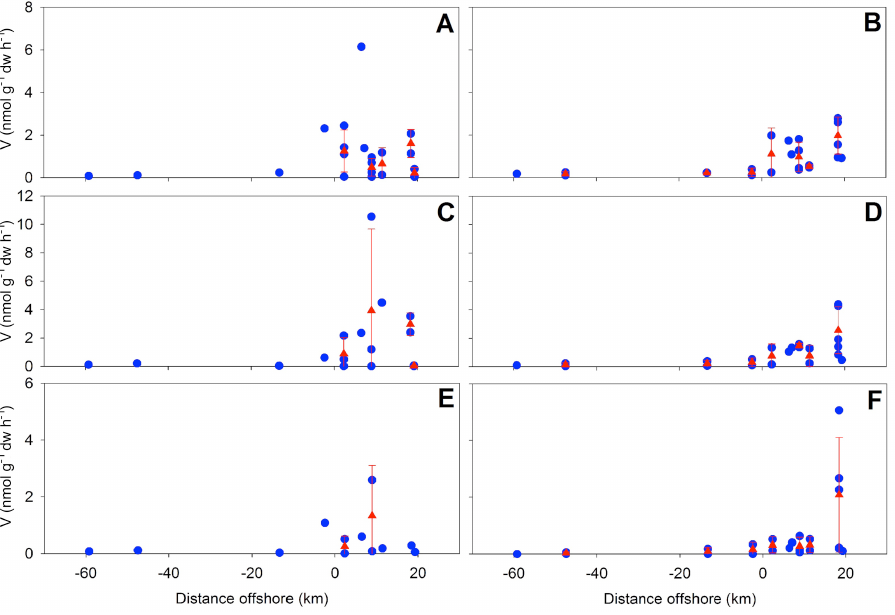
787 Fig. 7. Enzymatic extracellular hydrolysis of substrates MCA-leu ( A, B ), MUF-glu ( C, D ), MUF-cel ( E, F ) in surface sediment during winter (left panels) and spring-summer (right panels) in relation to distance from the coast (negative distances represent river sampling sites). Rates are in nmoll − 1 h − 1 . Blue symbols are discrete values and red symbols are average rates ( ± SD) when possible.